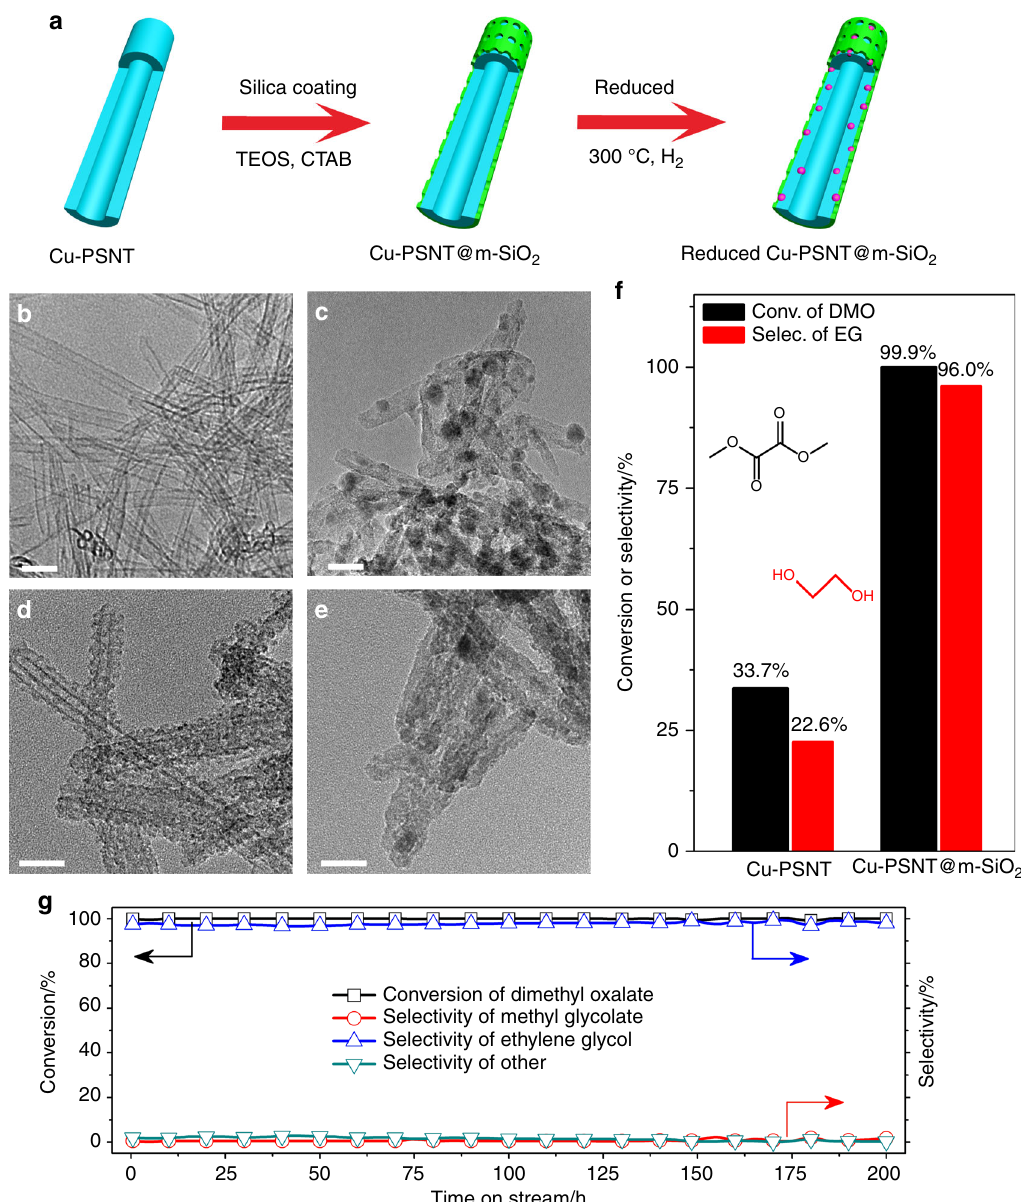
Fig. 4 Con fi ned growth strategy for maximizing Cu – O – SiO x interface. a Illustration of the synthetic strategy for the preparation of Cu-PSNT@m-SiO 2 ; b – e TEM image of as-prepared Cu-PSNT, reduced Cu-PSNT, Cu-PSNT@m-SiO 2 and reduced Cu-PSNT@m-SiO 2 , respectively; f Catalytic performance of reduced Cu-PSNT and reduced Cu-PSNT@ m-SiO 2 for the selective hydrogenation of DMO to EG (LHSV = 7.8 h − 1 ); g Catalytic performance of reduced Cu-PSNT@m-SiO 2 catalyst as a function of time-on-stream (LHSV = 2.0 h − 1 ). Reaction conditions were as follows: H 2 /DMO = 80 mol/mol, P (H = 3.0 MPa, T = 200 °C. Scale bars are 20 nm for ( b – e 2 ) and selectivity for DMO hydrogenation to EG. As shown in Fig. 4f, a nearly 100 % conversion of DMO and a high selectivity of 96.0% to EG were achieved over the reduced Cu-PSNT@m- SiO 2 catalyst even at a LHSV as high as 7.8 h − 1 at 200 °C. Under the same catalytic conditions (high LHSV), the reduced Cu-PSNT only gave 33.7% conversion of DMO and 22.6% selectivity to EG.